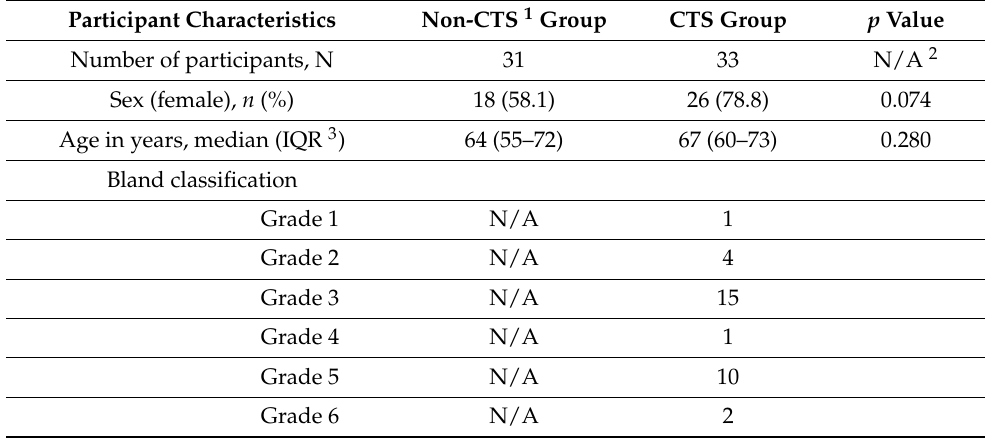
Table 2. Characteristics of participants in the CTS and non-CTS groups.